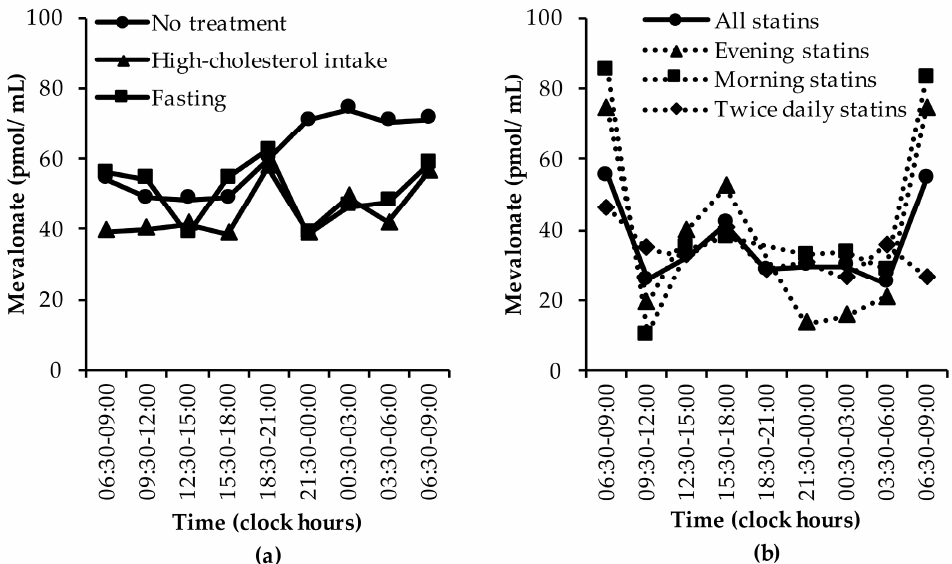
Figure 3. The diurnal rhythm of MVA concentrations: ( a ) in untreated subjects, in subjects who consumed high-cholesterol meals, and in subjects who fasted [28,30,31,33–35,37–39], and ( b ) in subjects who were treated with statins [37–39]. Data are presented as medians.